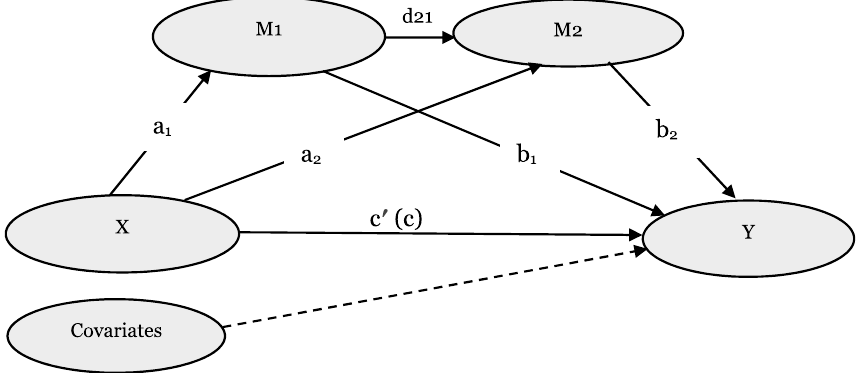
Figure 1. A hypothesized serial multiple mediation model. X is the predictor, M1 and M2 are mediators, and Y is the outcome variable.